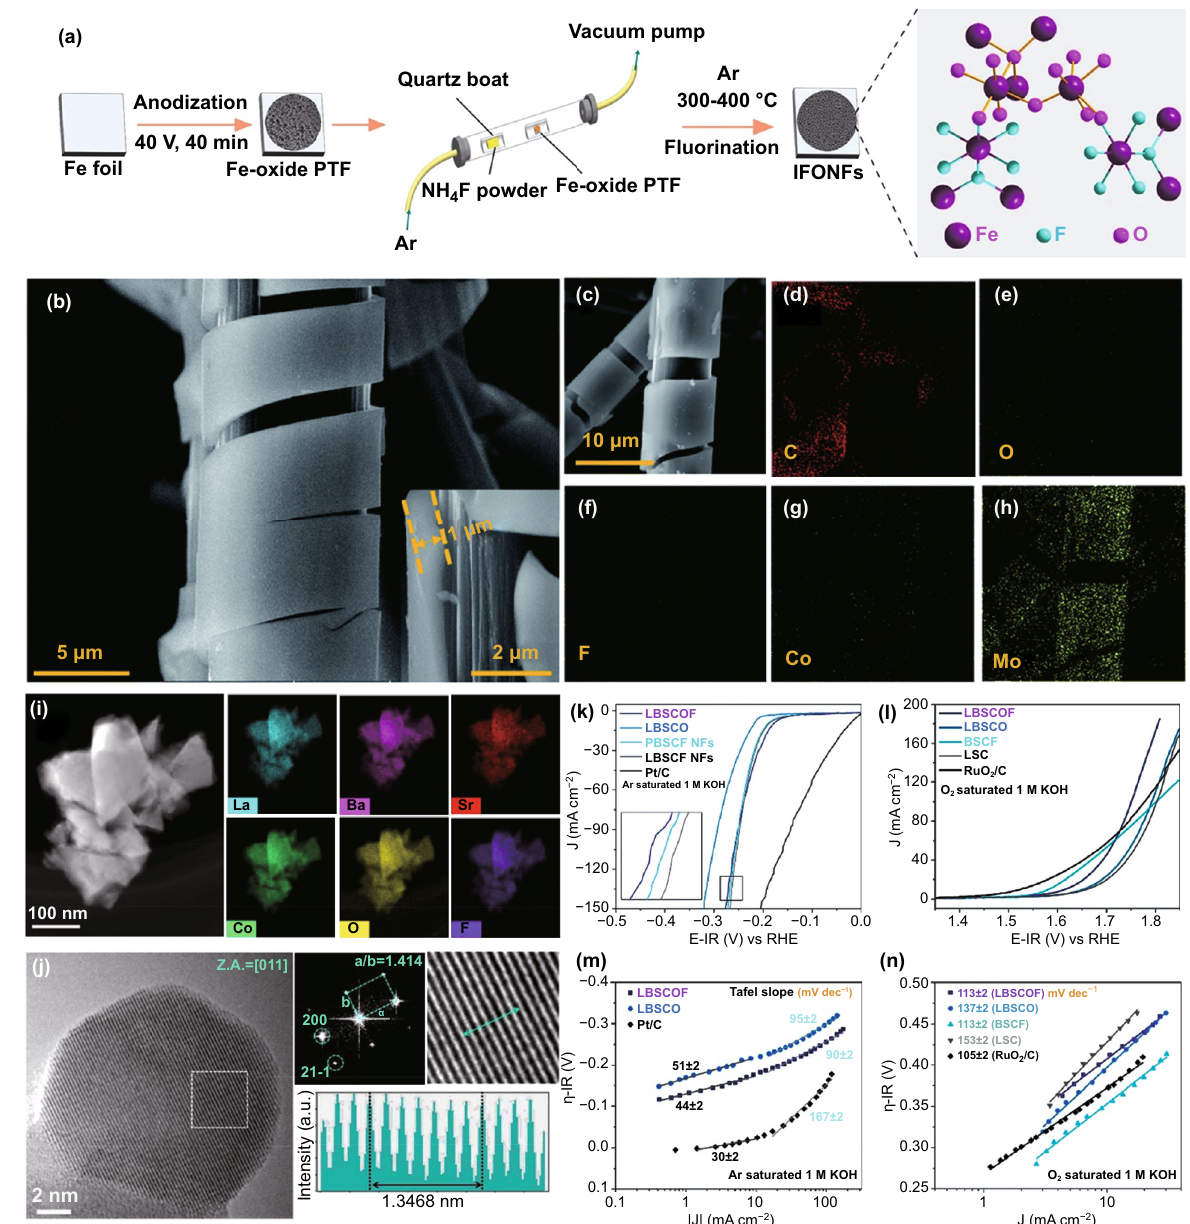
Fig. 5 a Schematic of the fabrication process for IFONFs, starting with a Fe foil. Reprinted with permission from Ref. [31]. Copyright Year 2018, Springer Nature. b SEM images for CoMoOF/GF. Inset: cross-sectional SEM image at a higher magnification, c–h SEM image for CoMoOF/GF and the corresponding EDS elemental mapping. Reprinted with permission from Ref. [108]. Copyright Year 2021, Royal Society of Chemistry. i Scanning transmission electron microscope (STEM)-energy dispersive X-ray spectroscopy (EDX) analysis of LBSCOF shows the uniform element distributions, j A typical high resolution transmission electron microscope (HRTEM) image of LBSCOF and the corre- sponding simulation results, k LSV curves and l Tafel plots and slopes for HER in Ar-saturated 1 M KOH, m LSV curves and n Tafel plots and slopes for OER in O 2 -saturated 1 M KOH. Reprinted with permission from Ref. [104]. Copyright Year 2018,